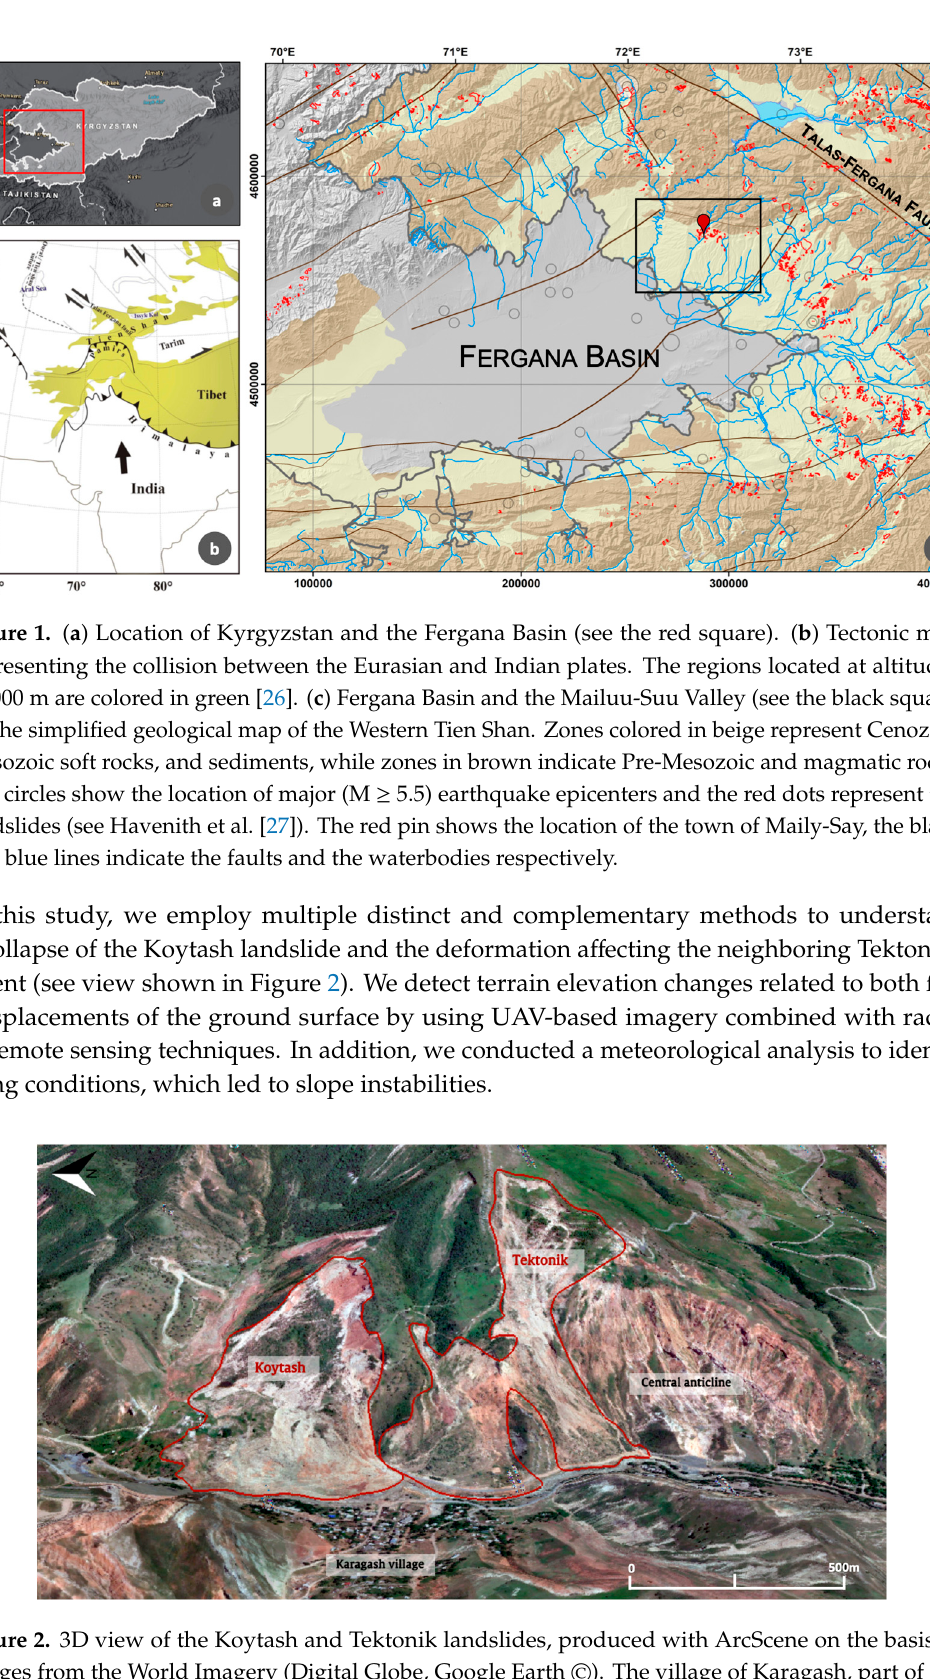
Figure 2. 3D view of the Koytash and Tektonik landslides, produced with ArcScene on the basis of images from the World Imagery (Digital Globe, Google Earth © ). The village of Karagash, part of the larger town of Maily-Say, is located in the foreground, and the central anticline is on the right.